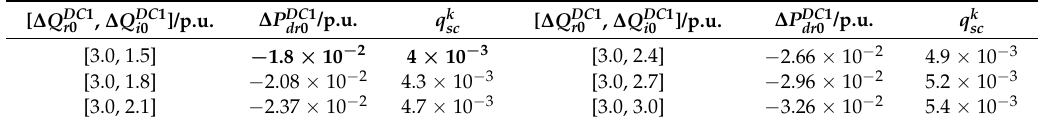
Table 1. Reactive power values absorbed by SCs and variations of DC power support values for HVDC Link